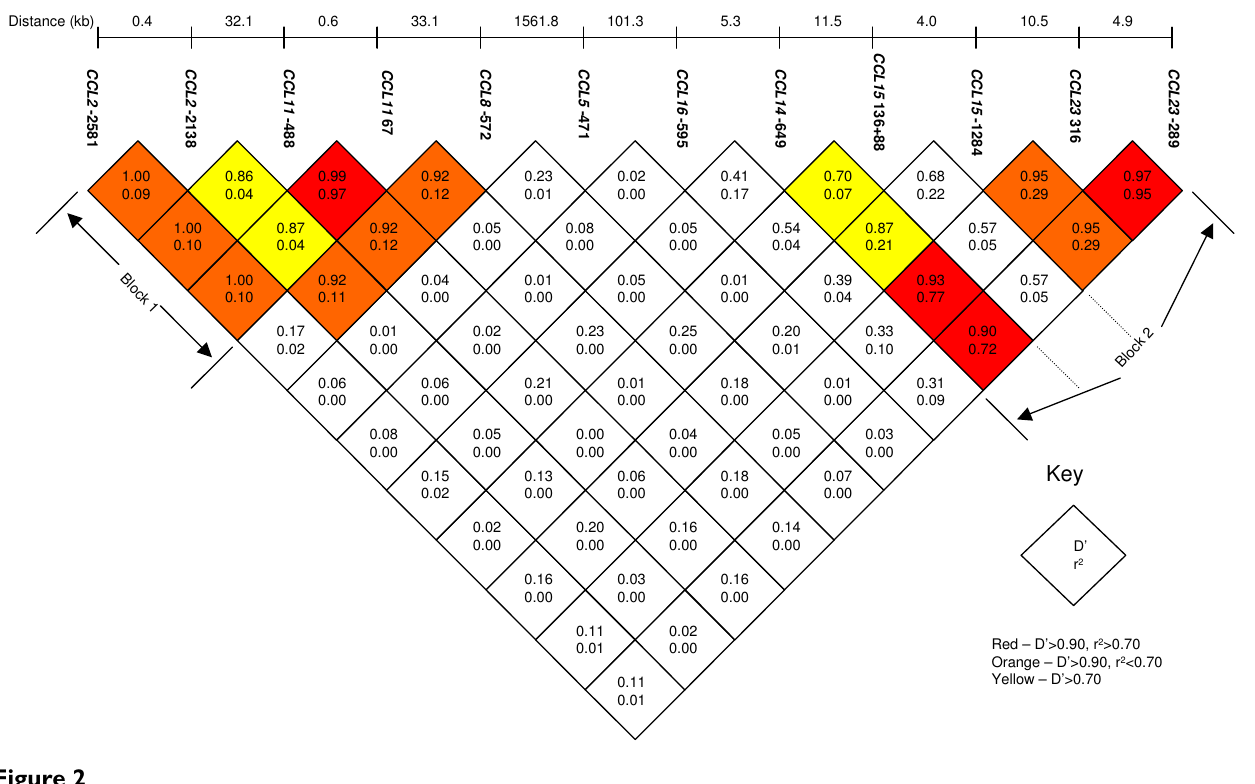
LD plot of CC chemokine gene cluster SNPs Figure 2